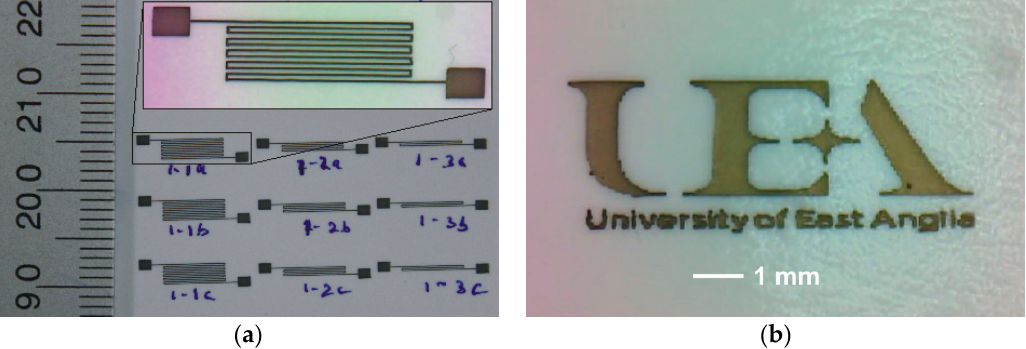
Figure 3. Optical images of ( a ) printed 2D circuit patterns and pads alongside ruler scale for reference and ( b ) University of East Anglia logo printed with feature size 85 µm and dot spacing 65 µm with a nozzle diameter 50 µm.